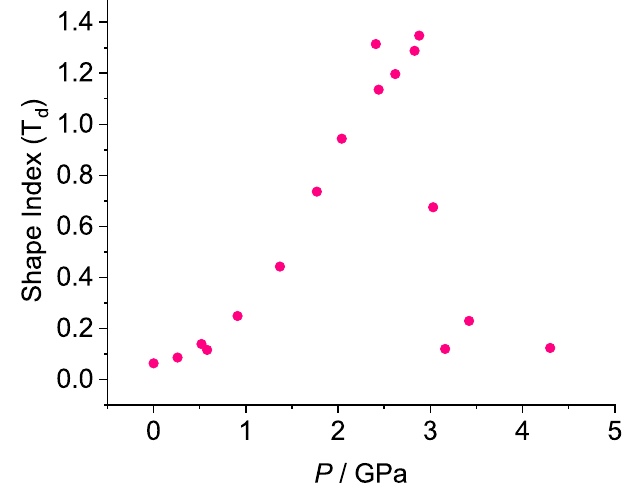
Fig. 5 | Shape index relative to ideal T d point symmetry for Th(OAr) 4 as a function of pressure. Plots for the U and Np complexes are available in Supple- mentaryFig.11.Aperfecttetrahedronwouldhaveashapeindexrelativeto T d point symmetry equal to